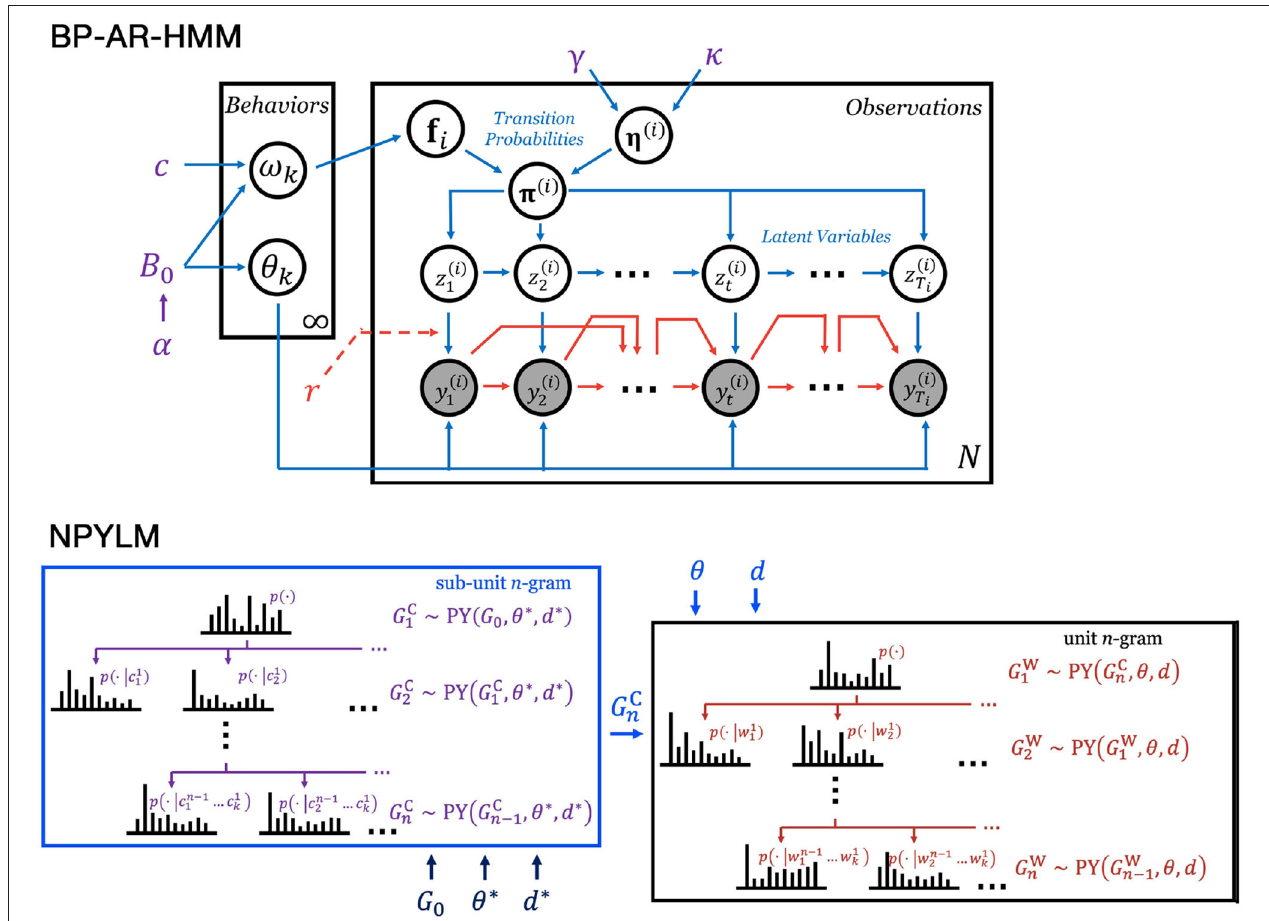
FIGURE 2 | Graphical representations of the non-parametric Bayesian models. (Top) BP-AR-HMM. (Bottom) NPYLM.